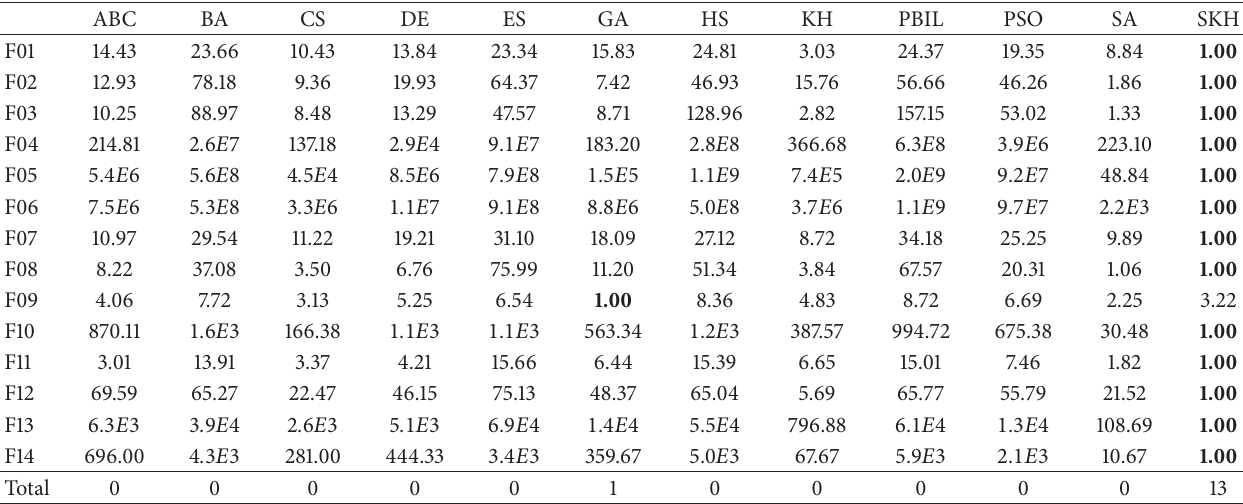
Table 2: Best normalized optimization results in fourteen benchmark